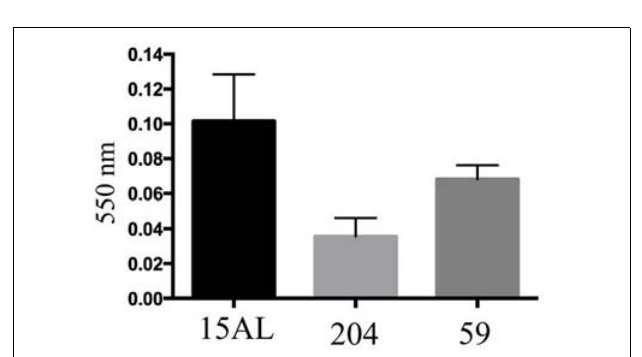
FIGURE 7 | Biofilms’ mass of three S. aureus strains measured by crystal violet staining. Biofilms were grown for 48 h and stained with crystal violet. The biofilms’ mass was quantified by measuring the optical density of crystal violet at 550 nm using spectrophotometer.